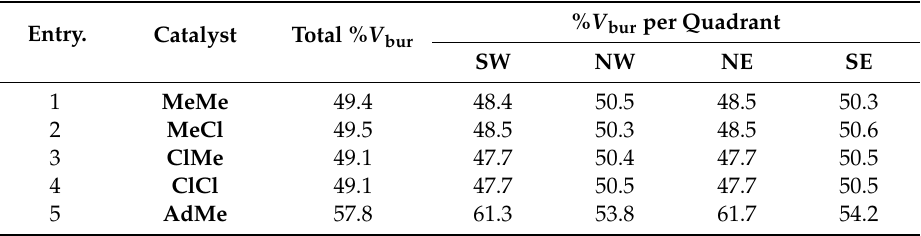
Table 2. Results of buried volume analysis for catalysts R 1 R 2 .